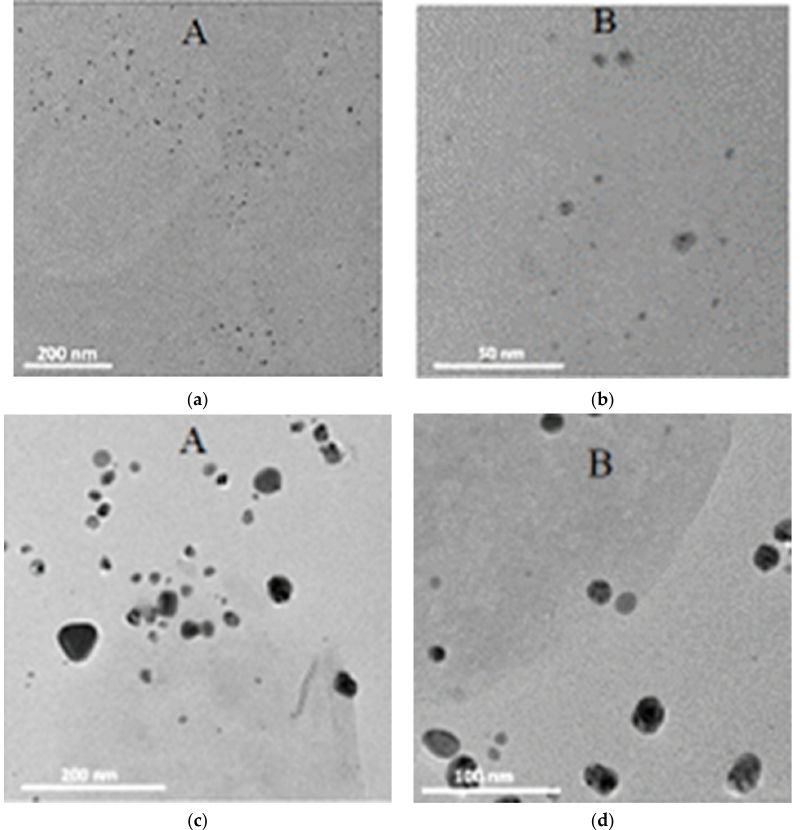
Figure 4. Electron micrographs of the hydrogels with silver nanoparticles at different concentrations: 1 mM on the 200 nm scale ( a ) and 50 nm scale ( b ); 4 mM on the 200 nm ( c ) and 100 nm scale ( d ).